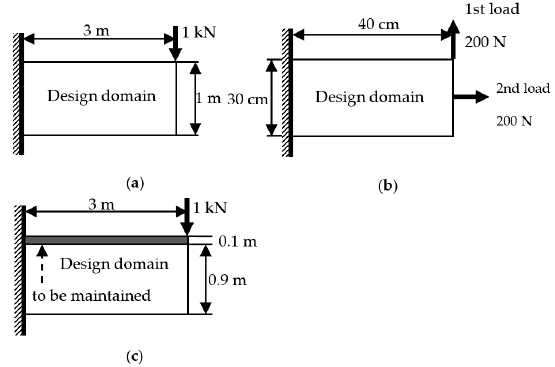
Figure 3. Structural design domains: ( a ) design domain of MOP1 & MOP3; ( b ) design domain of MOP2; ( c ) design domain of MOP 4 [8].